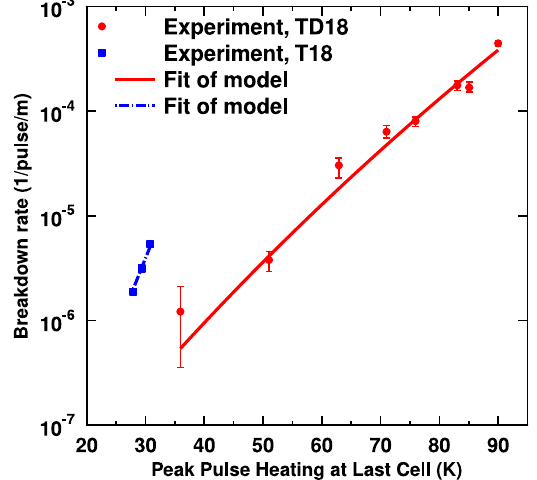
FIG. 5. Experimental data on dependence of breakdown rate on the peak temperature increase in accelerating components. The experimental data are from Ref.